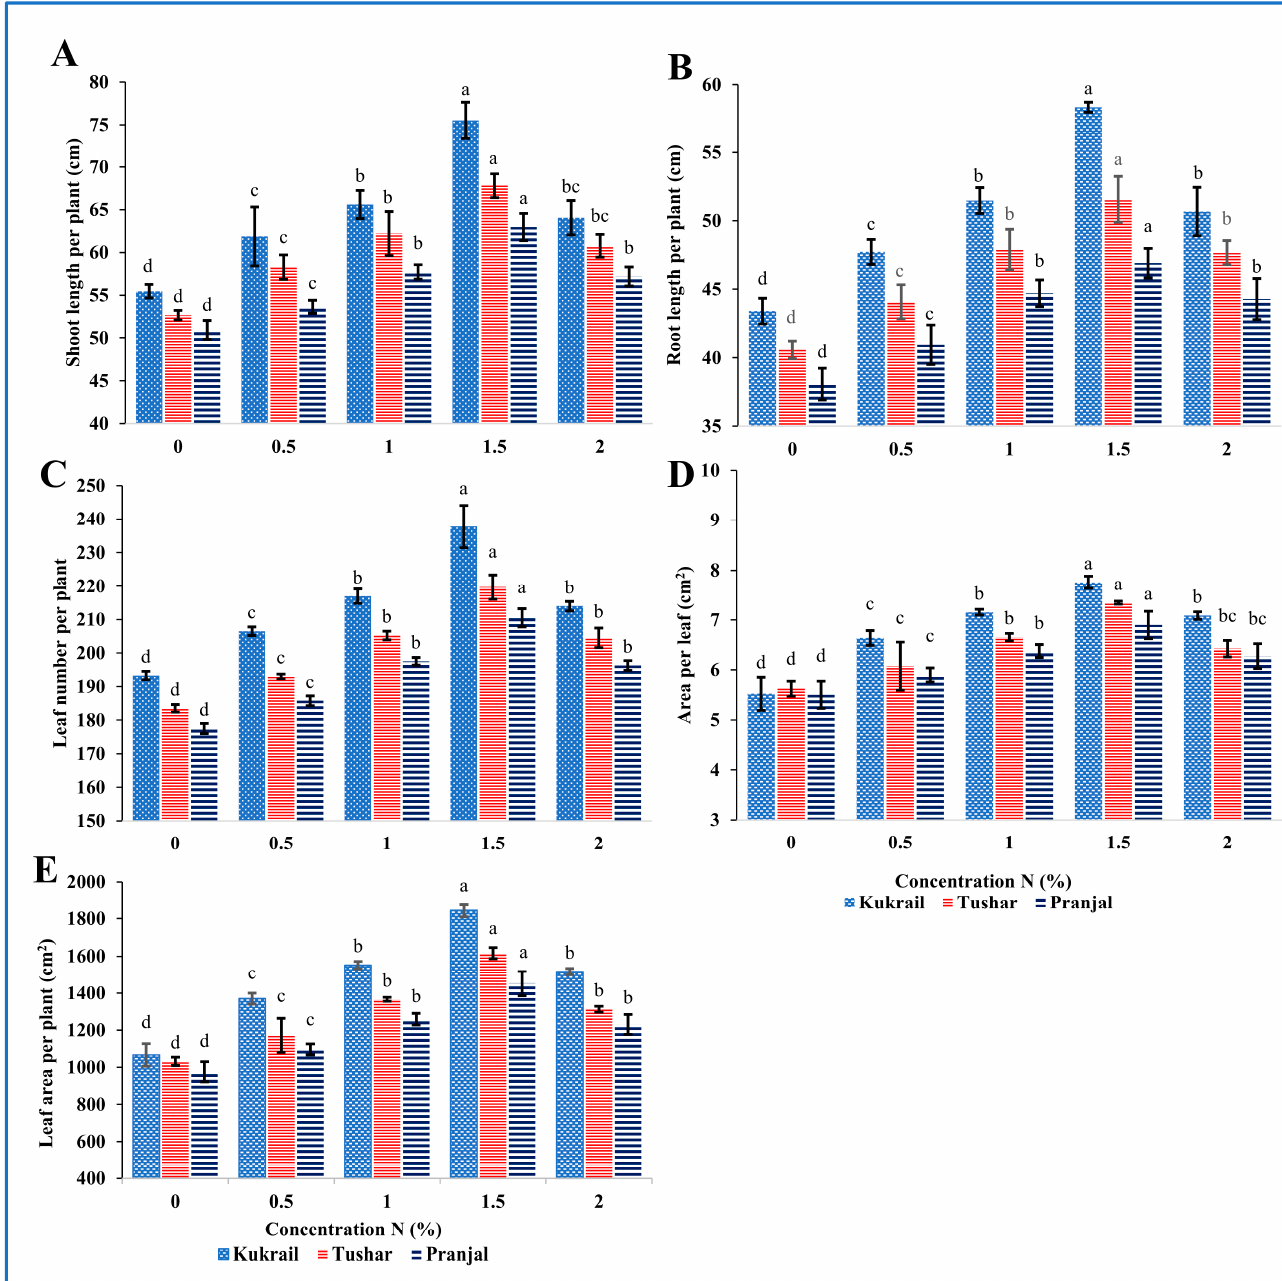
Figure 1. Effect of N on three cultivars: ( A ) Shoot length per plant, ( B ) Root length per plant, ( C ) Leaf number per plant, ( D ) Area per leaf, ( E ) Leaf area per plant of the three peppermint cultivars. Data represent the mean and bars represent the standard error (SE) of four replicates ( n = 4) of each cultivar. The letters over bars represent significance at p ≤ 0.05 by Duncan’s Multiple Range Test (DMRT).